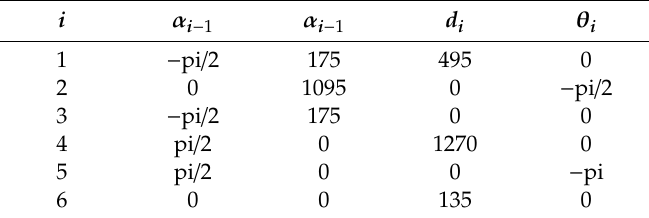
Table 2. Manipulator Denavit-Hartenberg (DH) parameters.